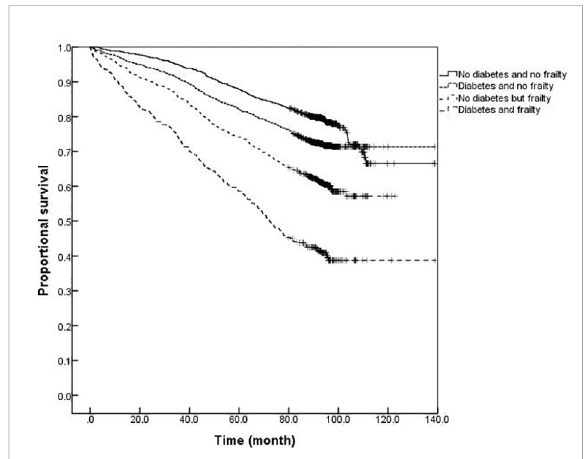
FIGURE 3 Kaplan-Meier curves for the proportional survival of total population with different diabetes and frailty status.